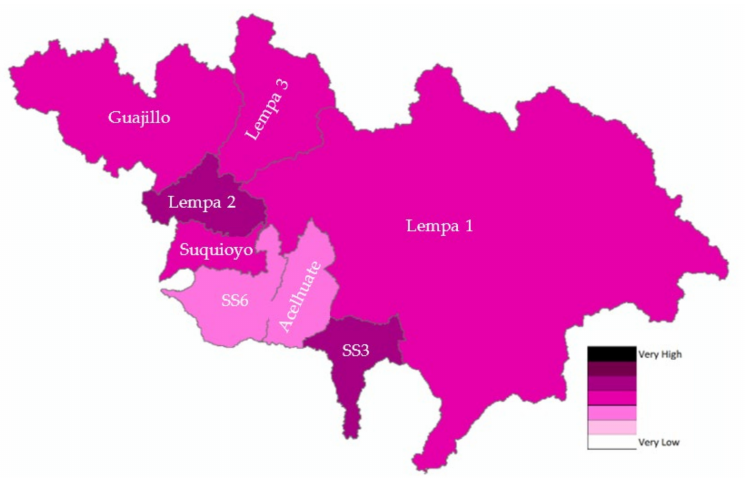
Figure 11. Spatial variation of drought resilience index (DREI) in eight sub-basins of Lempa River basin based on SEDI06.